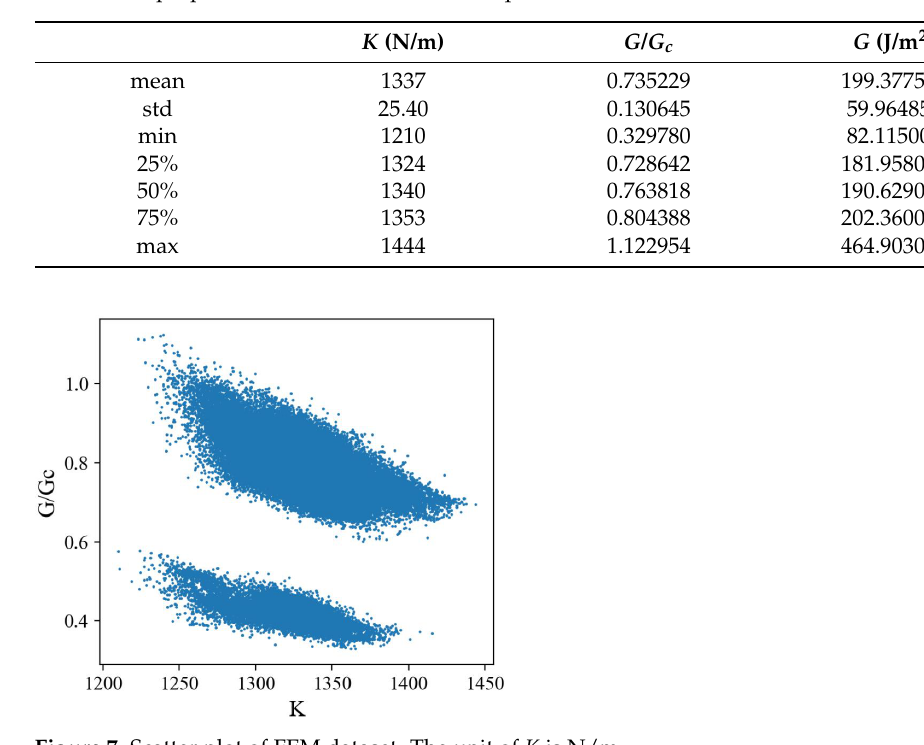
Figure 7. Scatter plot of FEM